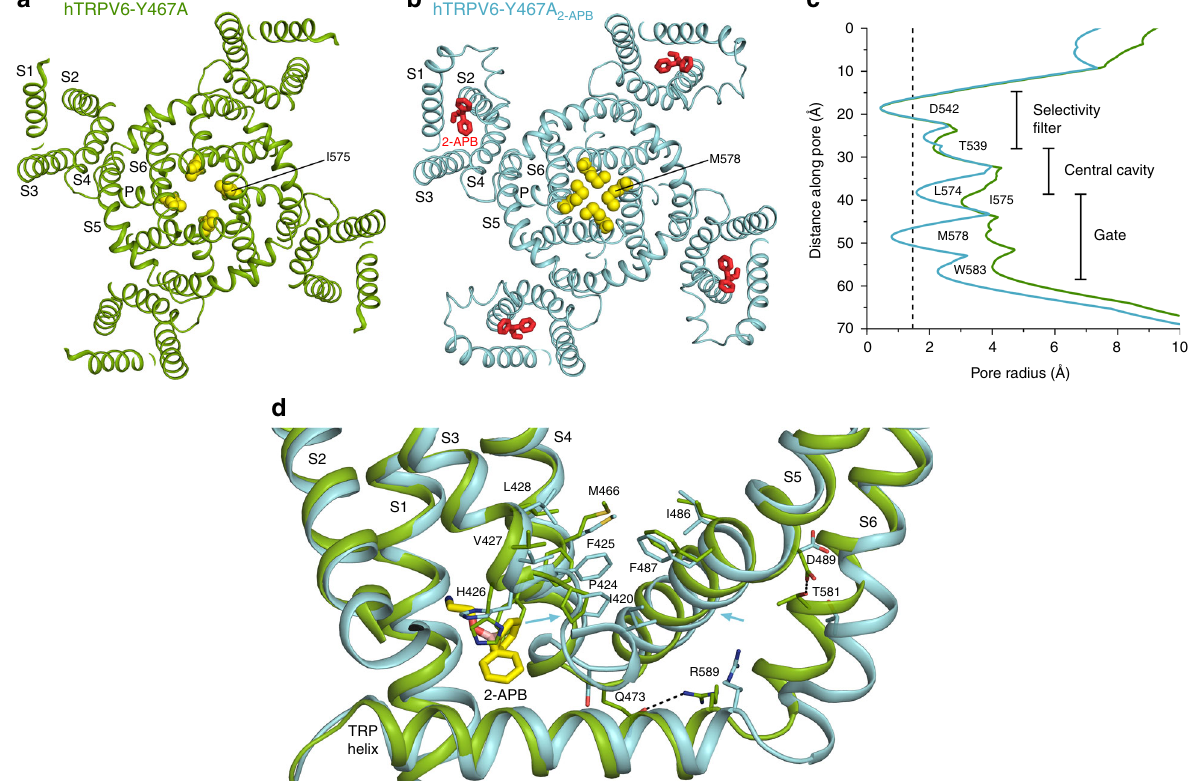
Fig. 8 Open and closed pores in cryo-EM structures of hTRPV6-Y467A and hTRPV6-Y467A 2-APB and 2-APB-induced conformational changes. a , b Intracellular view of the transmembrane domain in open-pore hTRPV6-Y467A ( a ) and closed-pore hTRPV6-Y467A 2-APB ( b ). Residues forming the narrowest part of the pore in the gate region, I575 in hTRPV6-Y467A ( a ) and M578 in hTRPV6-Y467A 2-APB ( b ), are shown as space- fi lling models (yellow). Molecules of 2-APB are shown as sticks (red). c Pore radius calculated using HOLE 66 for hTRPV6-Y467A (green) and hTRPV6-Y467A 2-APB (cyan). d Superposition of hTRPV6-Y467A (green) and hTRPV6-Y467A 2-APB (cyan), with hydrophobic residues, residues involved in 2-APB binding, residues important for gating, and 2-APB shown as sticks. Blue arrows illustrate movement of the hydrophobic residues to form the hydrophobic cluster. Dashed lines illustrate hydrogen bonds that stabilize the open